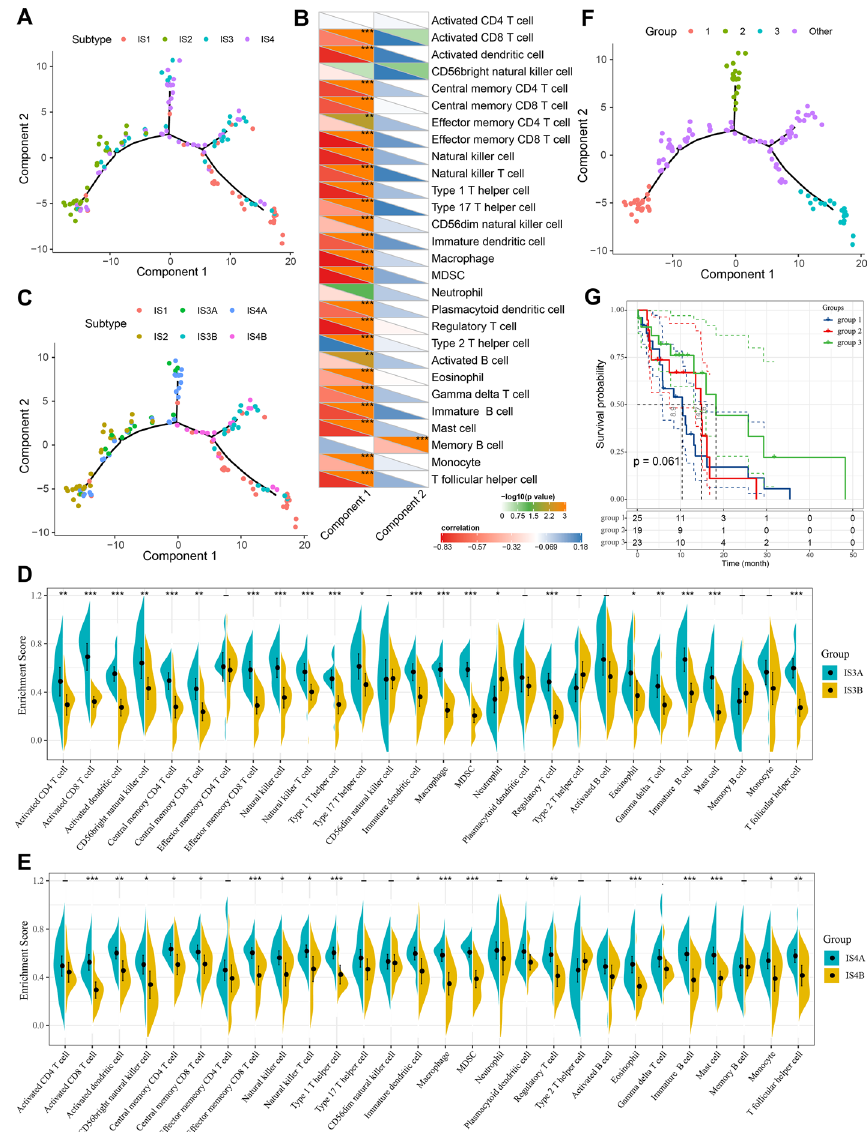
1, and the vertical axis represents the principal component 2. b Correlation between principal component 1/2 and 28 immune cell enrichment scores. c Immune landscape of the subgroups of GBM immune subtypes. Differences of 28 immune cells enrichment scores in the subgroups of IS3 ( d ) and IS4 ( e ). Immune landscape of samples from three extreme locations ( f ) and their prognostic status ( g ). −